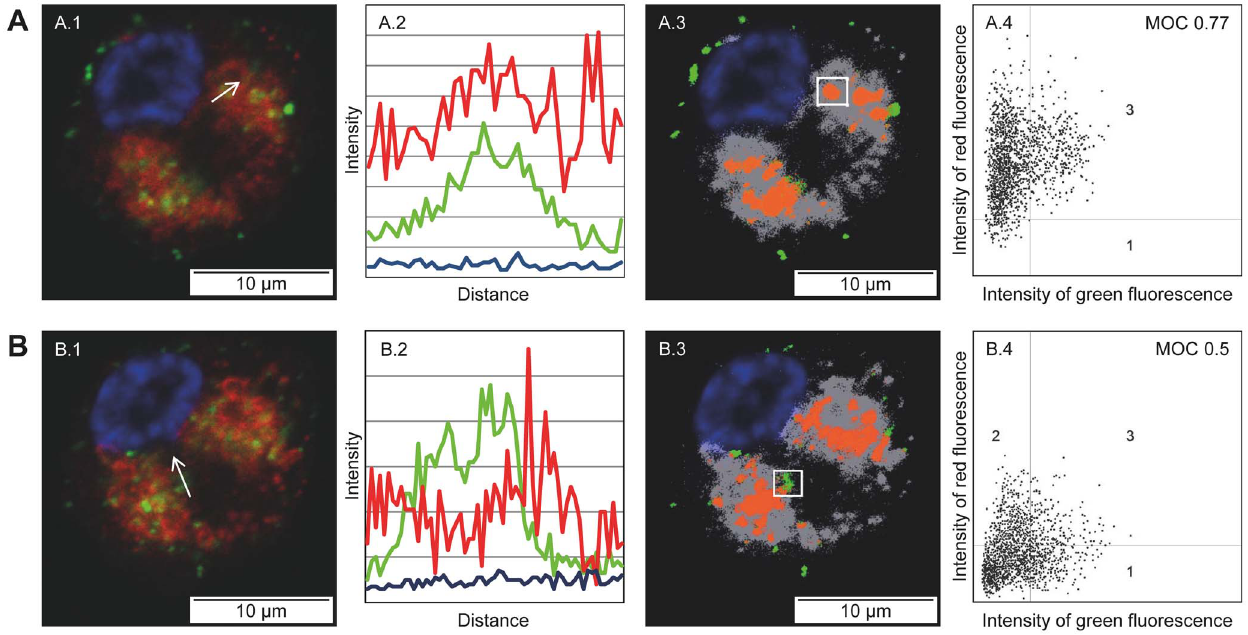
Figure 4. Whole virus vaccine material can be detected outside the endolysosomal compartment. Confocal LSM analysis was performed on immature DC after 4 h incubation with seasonal A/H3N2-Uruguay whole virus vaccine. DC were pre-treated with the irreversible proteasome inhibitor epoxomicin for 4 h before vaccine was added. (A) and (B) show two different sectional planes of the same DC that was selected as a representative example of the entire sample. A.1/B.1 show LSM pictures, including nucleus (Hoechst 33342) marked in blue color, endolysosomal compartment (Lamp1/Rab5) in red color, and nucleoprotein (NP) of H3N2 in green color, respectively. (A.2/B.2) Graphs represent the fluorescence intensity of staining dyes used in A.1/B.1. White arrows in A.1/B.1 mark the measuring points from basis to arrowhead. (A.3/B.3) To further analyze the localization of NP within the DC, A.1/B.1 pictures were post-processed. Blue color means Hoechst positive only, grey color means Lamp1/Rab5 positive only, orange color means Lamp1/Rab5 as well as NP positive, green color means NP positive only. Thresholds are indicated in A.4/B.4. (A.4/ B.4) Diagrams show the intensities of red (Lamp1/Rab5) and green (NP) fluorescence within white rectangles of A.3/B.3. To quantify colocalization of NP and Lamp1/Rab5 within the white rectangle of A.3/B.3 Mander’s overlap coefficient (MOC) was calculated. Value range 0–1 (0: no colocalization, 1: all pixels colocalize).